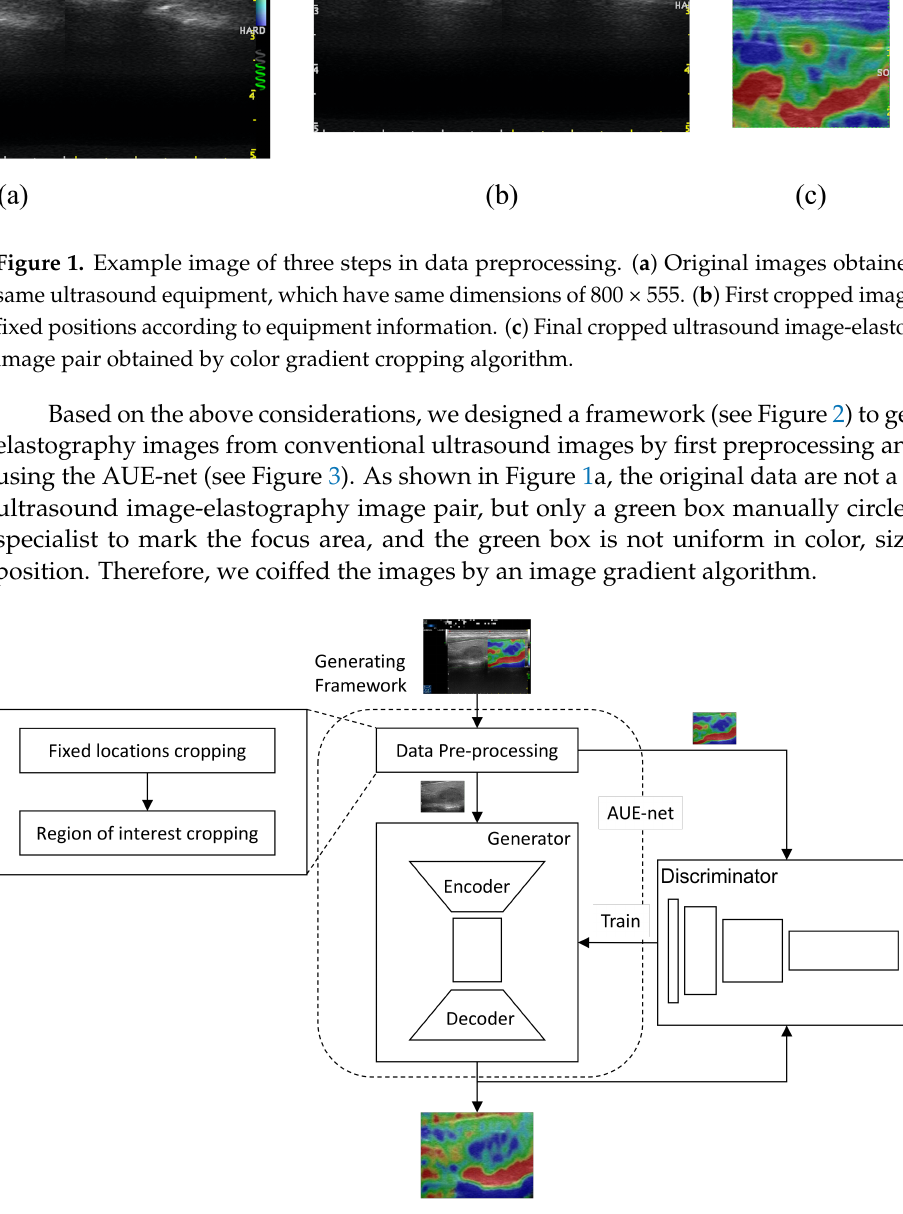
Figure 2. Whole flow of our generation